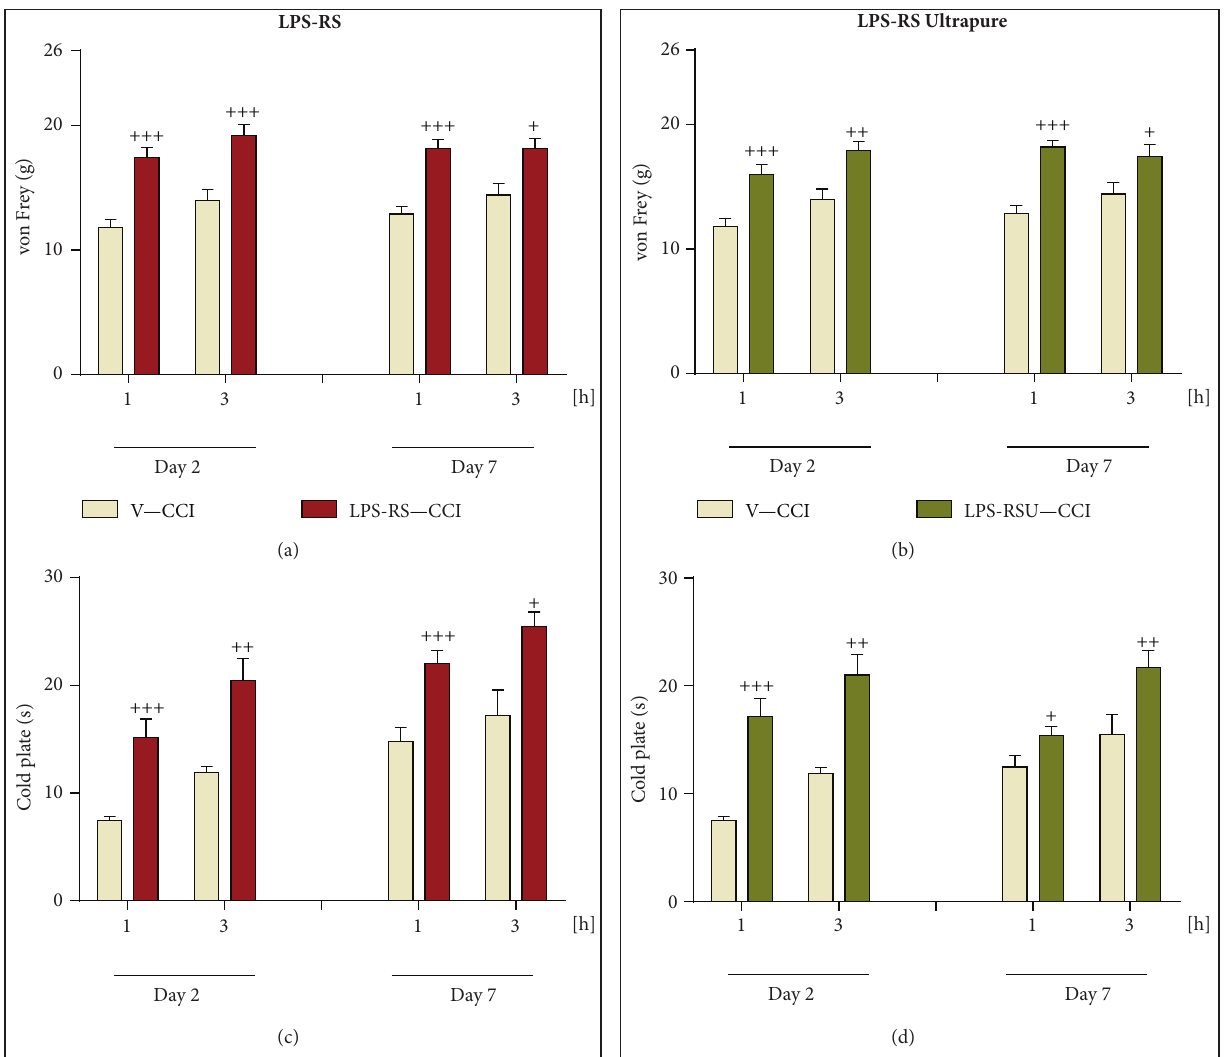
Figure 5: The influence of once daily, repeated intrathecal administration of vehicle (“V”, sterile water), LPS-RS [20 𝜇 g/5 𝜇 L], or LPS-RS Ultrapure [“LPS-RSU”, 20 𝜇 g/5 𝜇 L] on pain behavior, as measured by von Frey’s test (mechanical allodynia; (a), (b)) and the cold plate test (thermal hyperalgesia; (c), (d)), 1 and 3 hours after drug administration on 2nd and 7th days after chronic constriction injury (CCI) to the sciatic nerve. The data are presented as the mean ± SEM (10–25 rats per group). Intergroup differences were analyzed using one-way ANOVA followed by Bonferroni’s multiple comparisons test. + 𝑝 < 0.05 , ++ 𝑝 < 0.01 , and +++ 𝑝 < 0.001 indicate significant differences compared with the vehicle-treated, CCI-exposed rat group